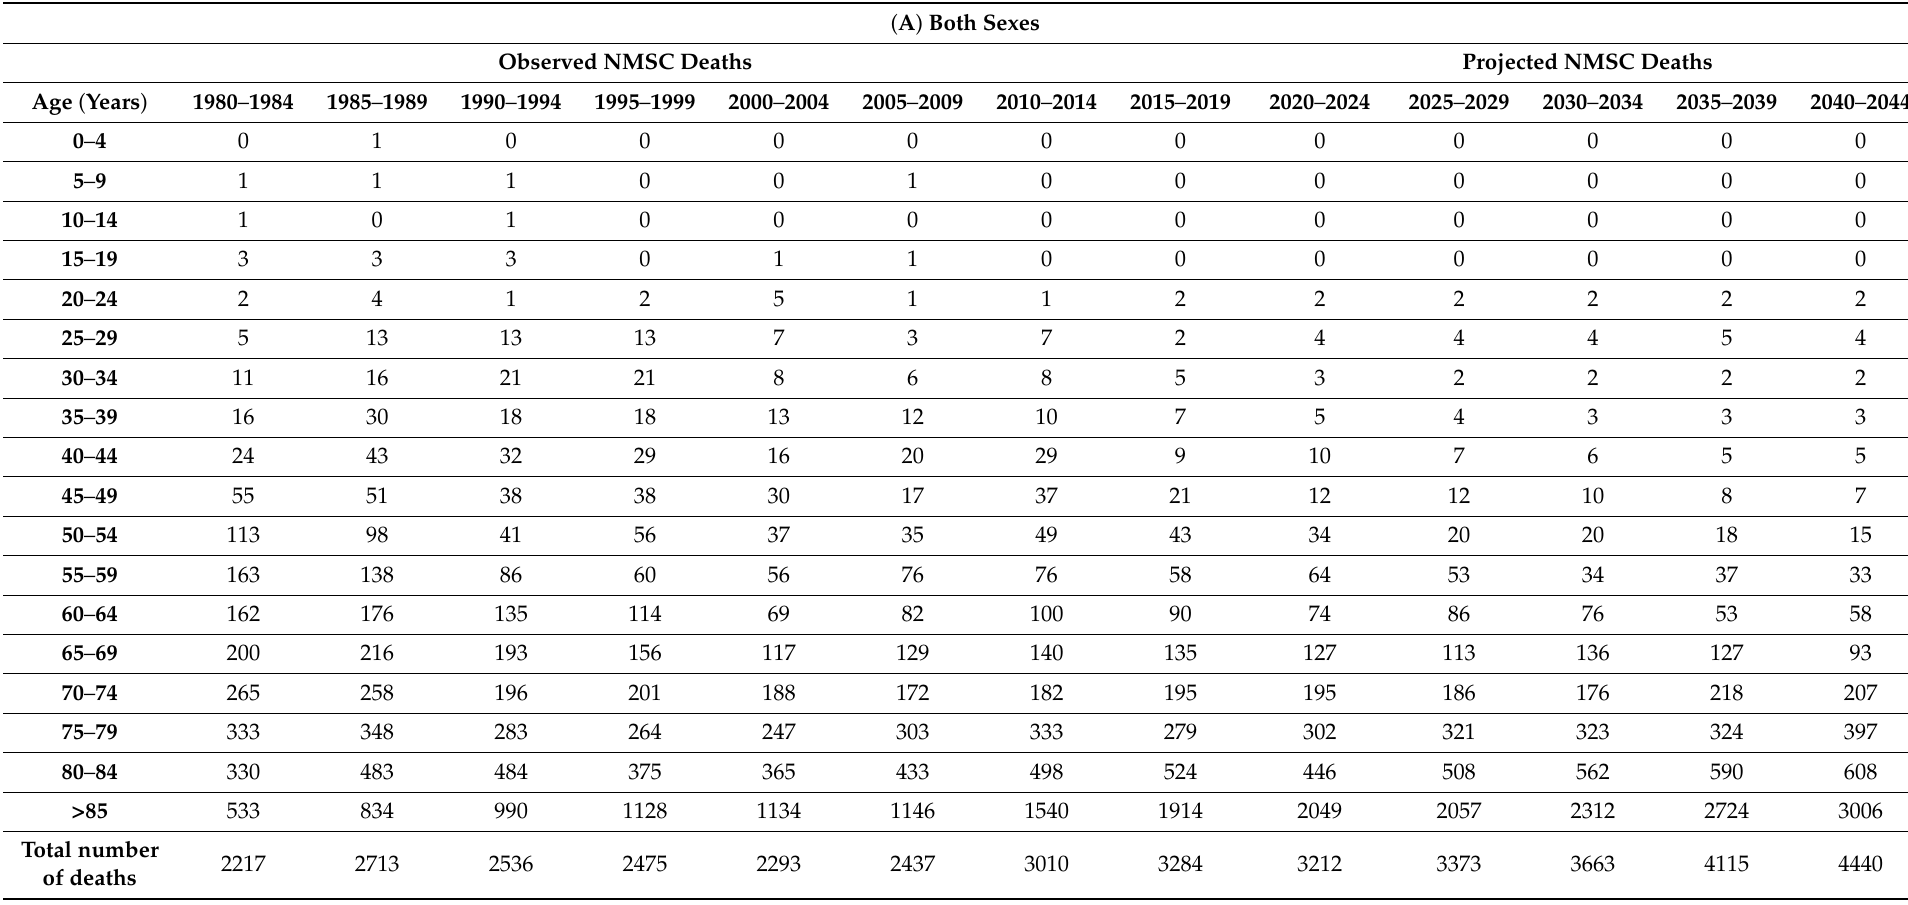
Table 1. Number of deaths observed (1980–2019) and projected (2020–2044) by periods and age groups by NMSC in Spain. ( A ) Both sexes; ( B ) men; ( C )